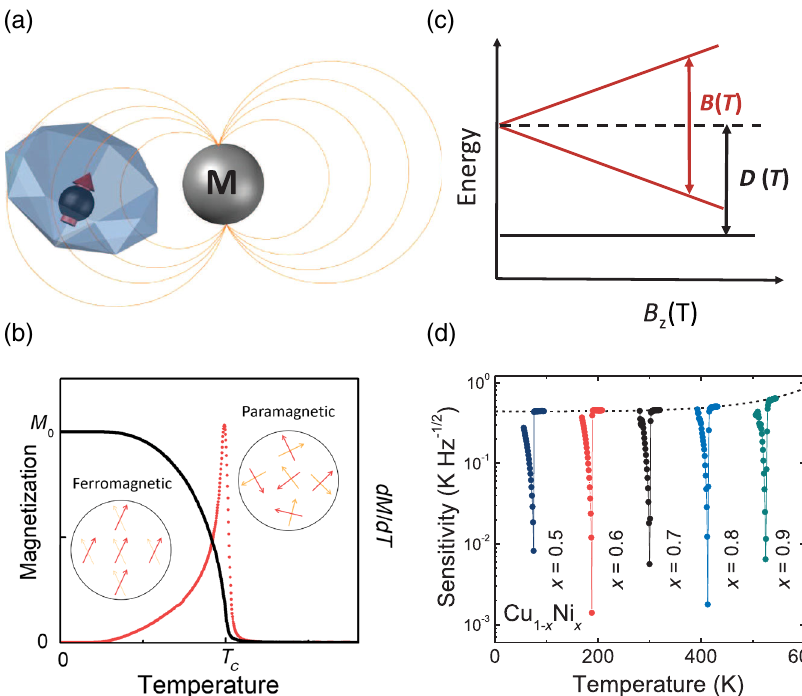
FIG. 1. Principle of magnetic criticality enhanced hybrid nanothermometers. (a) Schematic of a hybrid nanosensor, composed of a fluorescent nanodiamond (FND) and a magnetic nanoparticle (MNP). (b) The magnetic moment M (black solid line) of the MNP decreases dramatically with temperature increasing to the ferromagnetic-paramagnetic transition, with the temperature susceptibility dM / dT (red dotted line) peaking at the critical temperature T C . The transition frequencies of the NV center spins in the FND depend sensitively on the magnetic moment of the MNP and hence the temperature. (c) Fine structure of the NV center ground state as a function of an axial magnetic field. The zero-field splitting D varies with temperature with a rate dD / dT ≈ − 74 kHz/K. In the hybrid nanosensor, ð T Þ results in a much more sensitive dependence of the transition frequencies on the temperature. the magnetic field from the MNP B MNP (d) Theoretical sensitivity of the hybrid sensor composed of a FND and a Cu 1 − x Ni x MNP with different chemical composition x . The dashed line is the sensitivity of the bare NV-based thermal sensor. A spherical CuNi MNP with diameter of 200 nm is assumed. The FND is assumed of size ≈ 100 nm with 500 NV centers (randomly distributed and orientated) and located 65 nm away from the